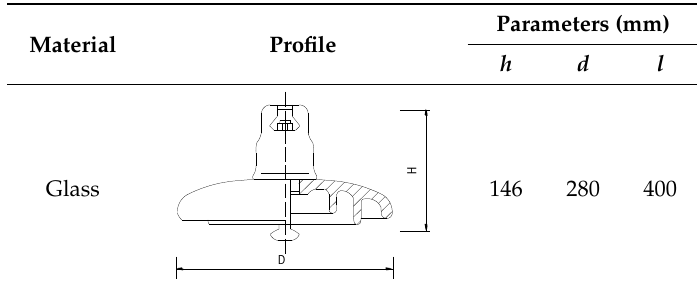
Table 2. Profile parameters of the insulator sample, h is the configuration height, l is the leakage distance, and d is the diameter of insulators.